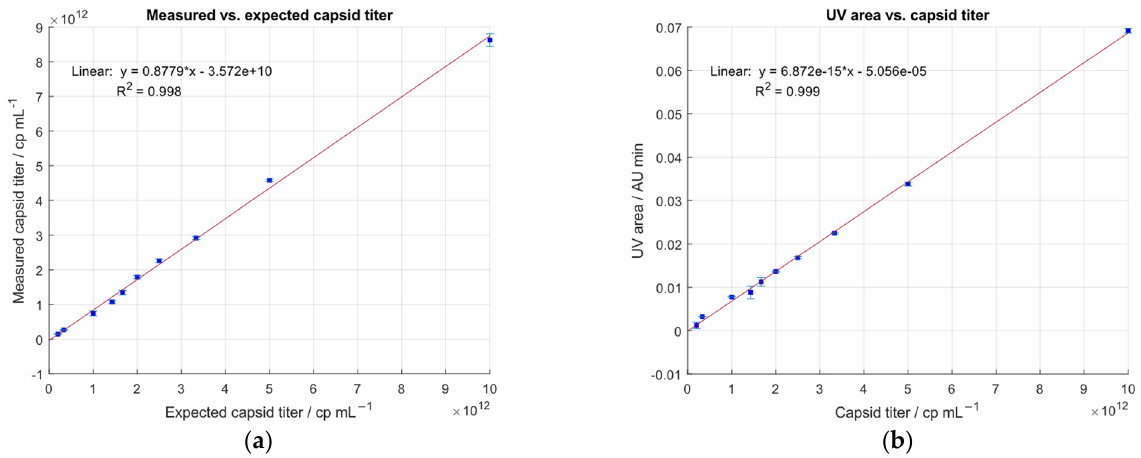
Figure 3. Linearity of the developed IEC-MALS method. Plots of expected capsid titers obtained by ELISA vs. (a) capsid titer measured with multi-angle light scattering and (b) UV area by integration of the UV profiles at 280 nm.